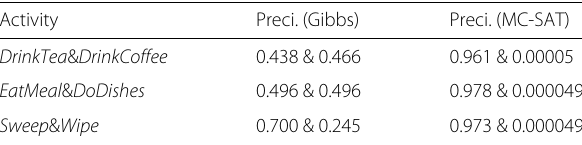
Table 3 Two similar activities’ probability Activity group Preci. (with series and periods)